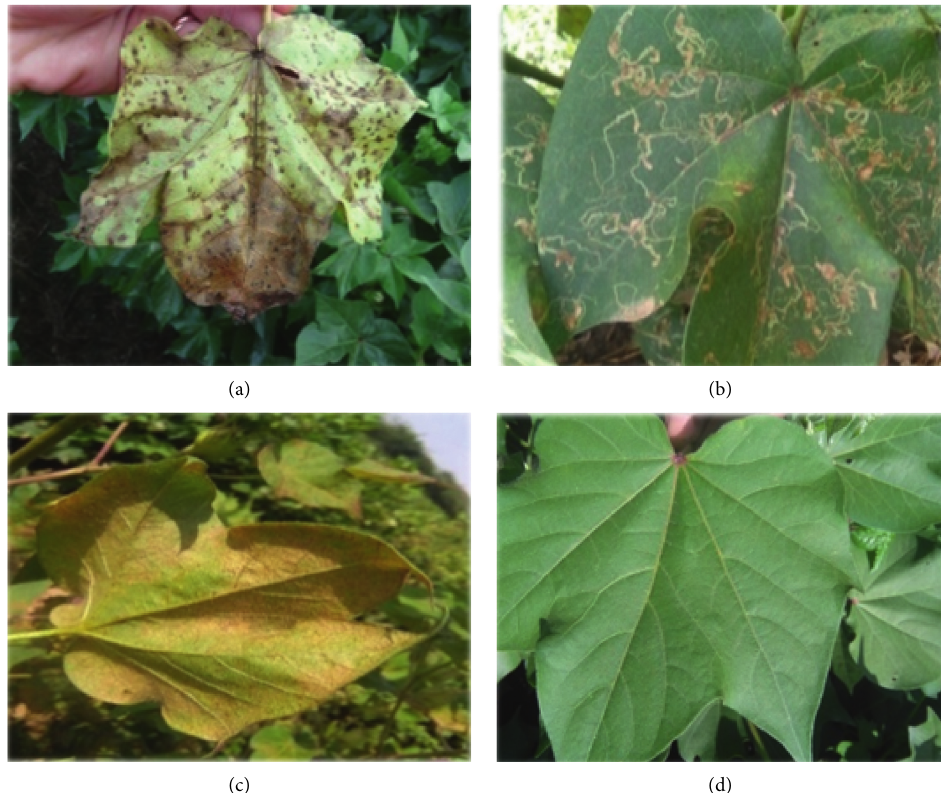
Figure 2: Dataset classes: (a) bacterial blight, (b) leaf miner, (c) spider mite, and (d) healthy.